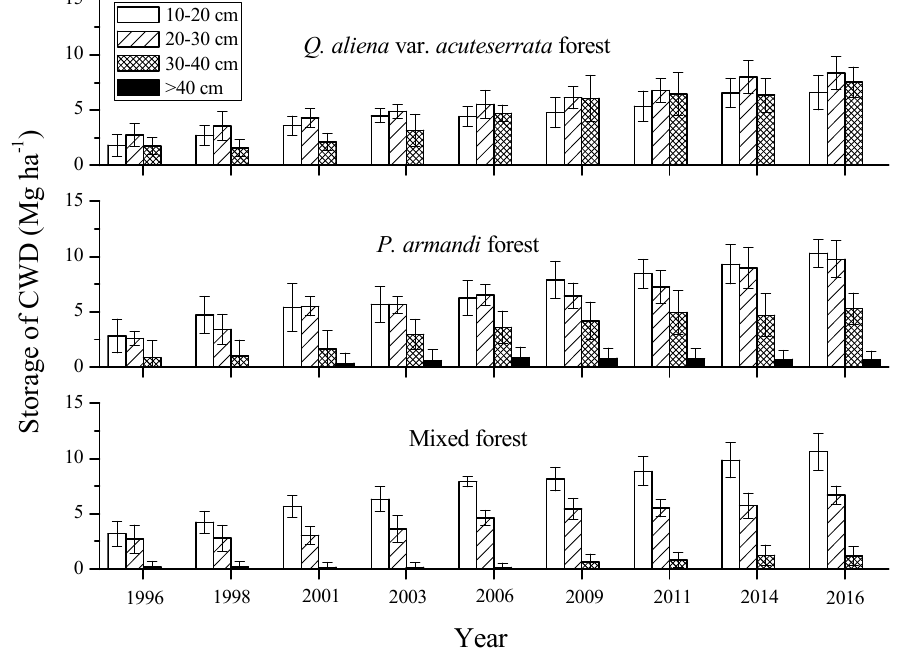
Figure 5. Mass of CWD diameter classes at the nine tree censuses during 1996–2016 for the three forest types in the Huoditang Experimental Forest Farm in the Qinling Mountains (China). The error bars represent the standard error of the mean, and are based on the plot as the experimental unit ( n = 6).